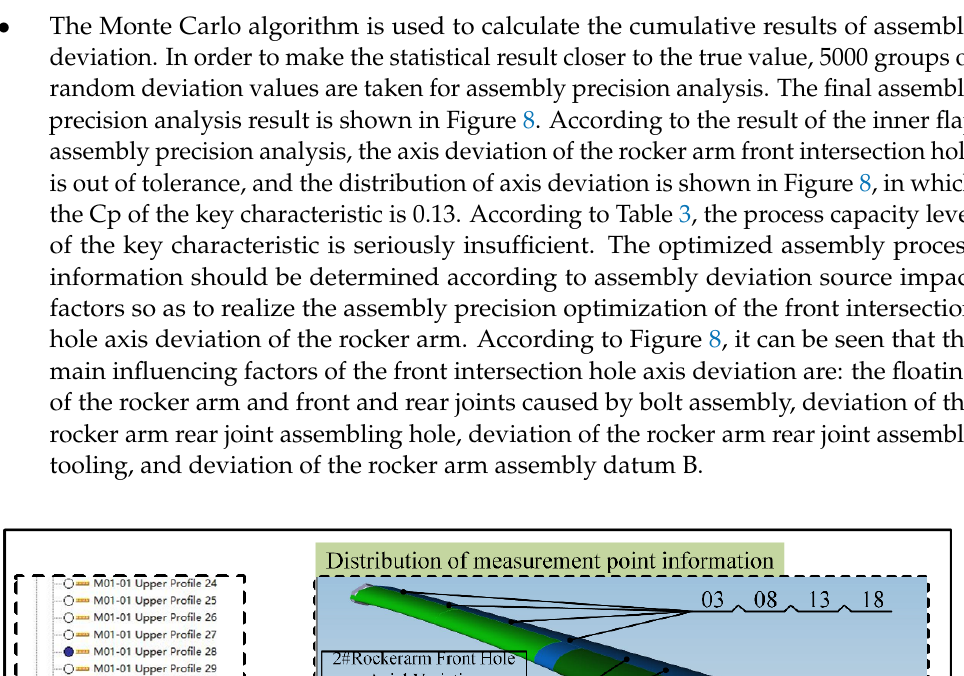
Figure 7. I nner flap geometric model. Figure 7. Inner flap geometric model.